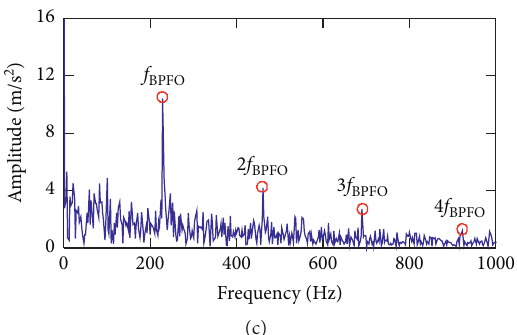
Figure 28: Processing results of denoising signal by the EMDF method: (a) correlation curve between FEF and scale λ ; (b) time-domain spectrum; (c) envelope spectrum.